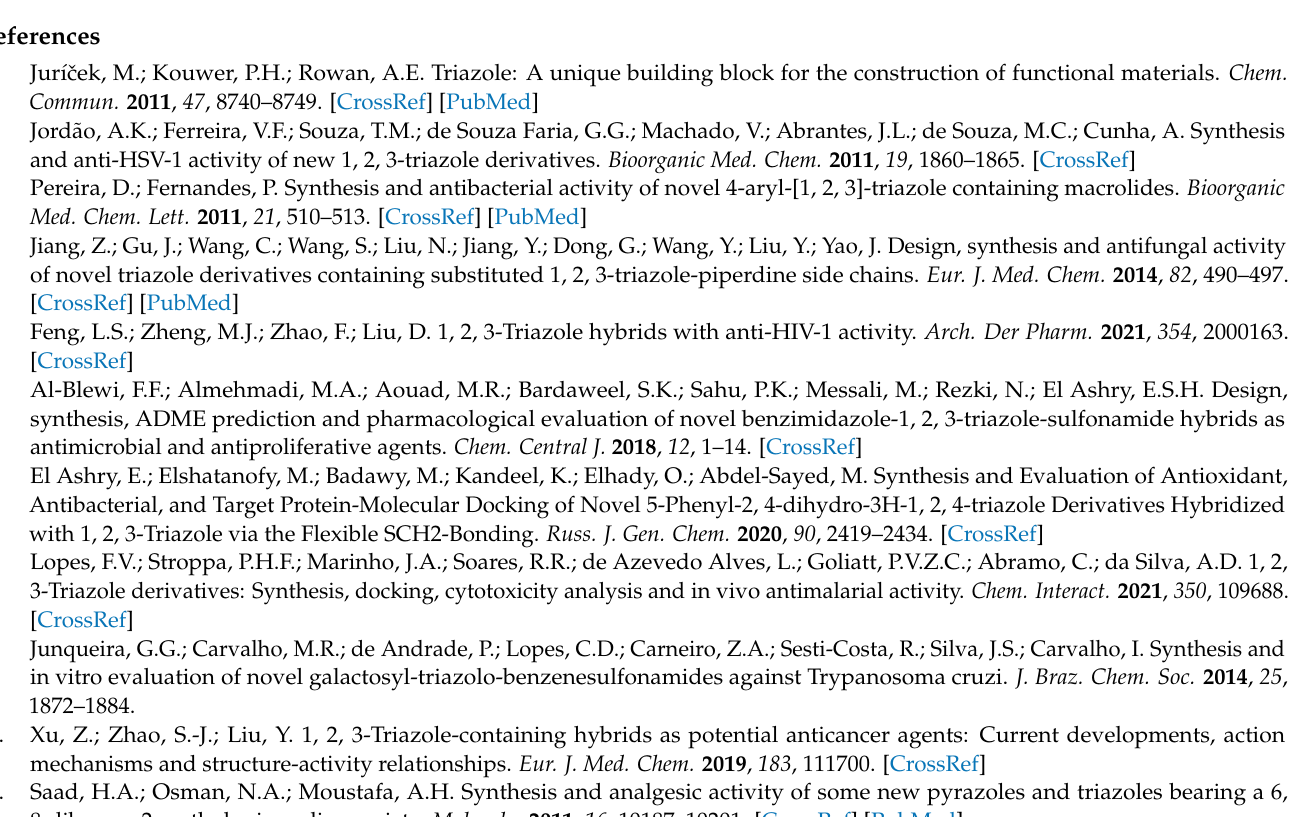
compound 2 , Figure S3: 13 C NMR spectrum of compound 2 , Figure S4: IR spectrum of compound 9, Figure S5: 1H NMR spectrum of compound 9 , Figure S6: 13 C NMR spectrum of compound 9 , Figure S7: 19 F NMR spectrum of compound 9 , Figure S8: IR spectrum of compound 11 , Figure S9: 1 H NMR spectrum of compound 11 , Figure S10: 13 C NMR spectrum of compound 11 , Figure S11: IR spectrum of compound 12 , Figure S12: 1 H NMR spectrum of compound 12 , Figure S13: 13 C NMR spectrum of compound 12 , Figure S14: 19 F NMR spectrum of compound 12 , Figure S15: IR spectrum of compound 13 , Figure S16: 1 H NMR spectrum of compound 13 , Figure S17: 13 C NMR spectrum of compound 13 , Figure S18: IR spectrum of compound 14 , Figure S19: 1 H NMR spectrum of compound 14 , Figure S20: 13 C NMR spectrum of compound 14